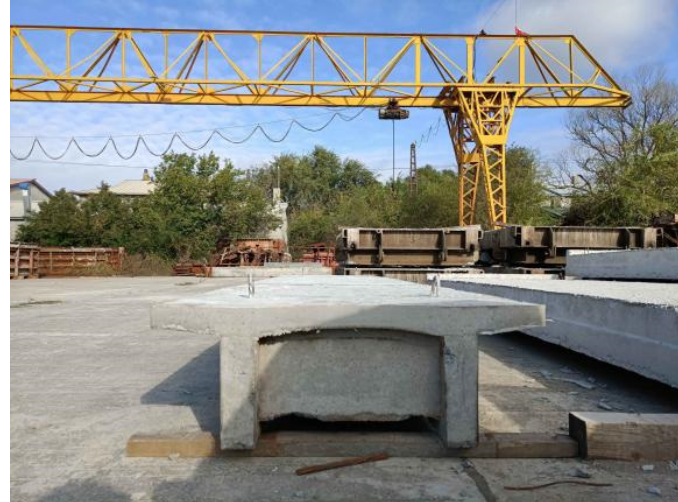
Figure 1. The model of the bridge slab.